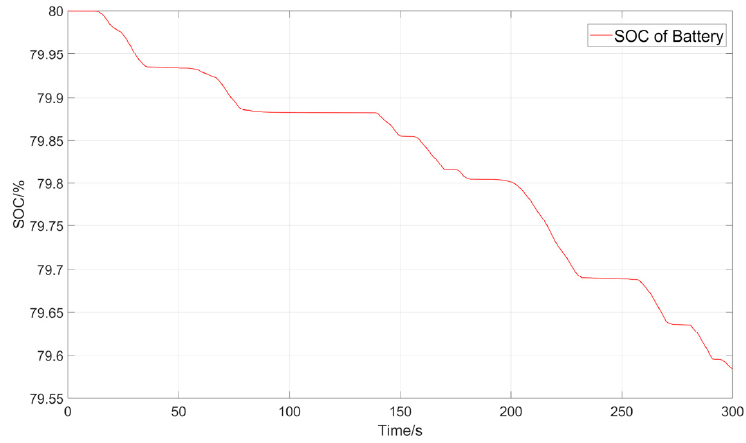
Figure 12. SOC level of battery.